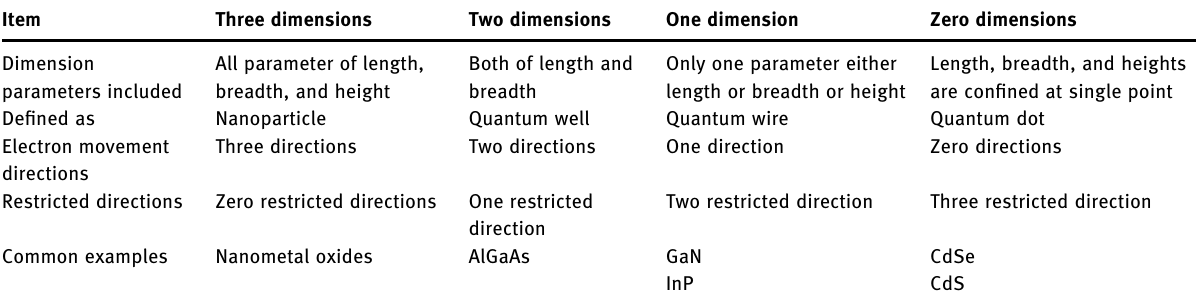
Table 2: Comparison of di ff erent con fi nement direction